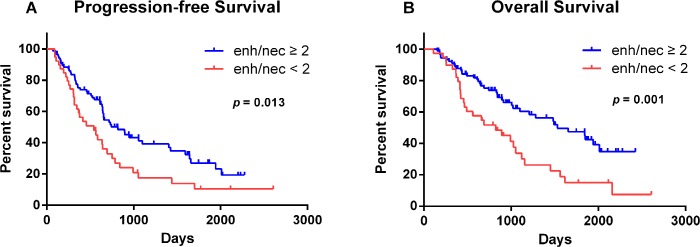
Kaplan-Meier estimates of survivals using volumetric ratio of enhancement to necrosis.Log-rank analysis indicated (A) a significant PFS advantage (log-rank, p = 0.013) and (B) a significant OS advantage (log-rank, p = 0.001) for patients with anaplastic gliomas with a high volumetric ratio (≥ 2) of enhancement to necrosis.